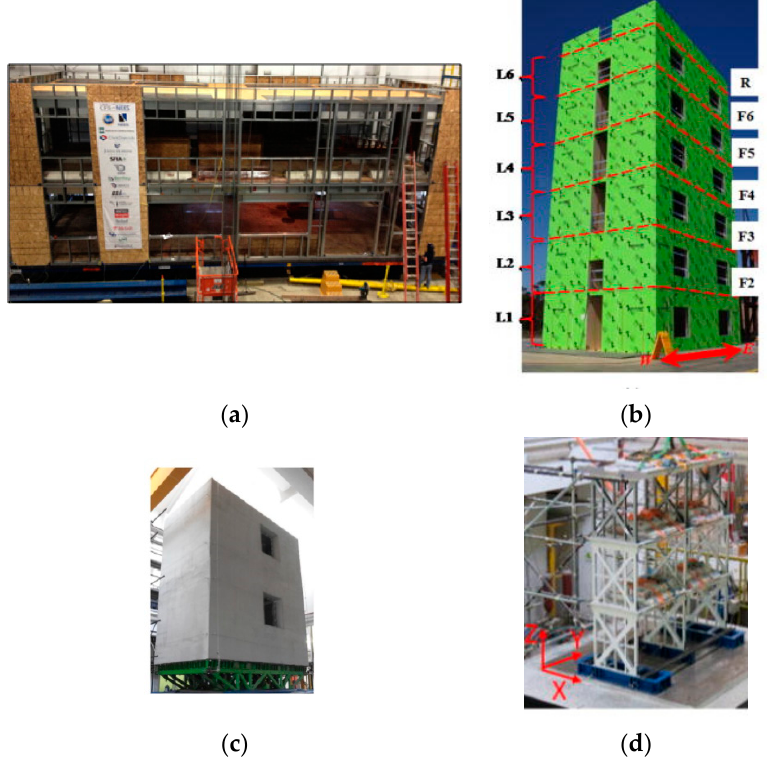
Figure 9. CFS building specimens tested on shaking table. ( a ) CFS building with wood sheathed shear walls [20]; ( b ) CFS building with combined gypsum-steel panel sheathed shear walls [21]; ( c ) CFS building with gypsum sheathed shear walls [22]; ( d ) scaled CFS building with strap-braced walls